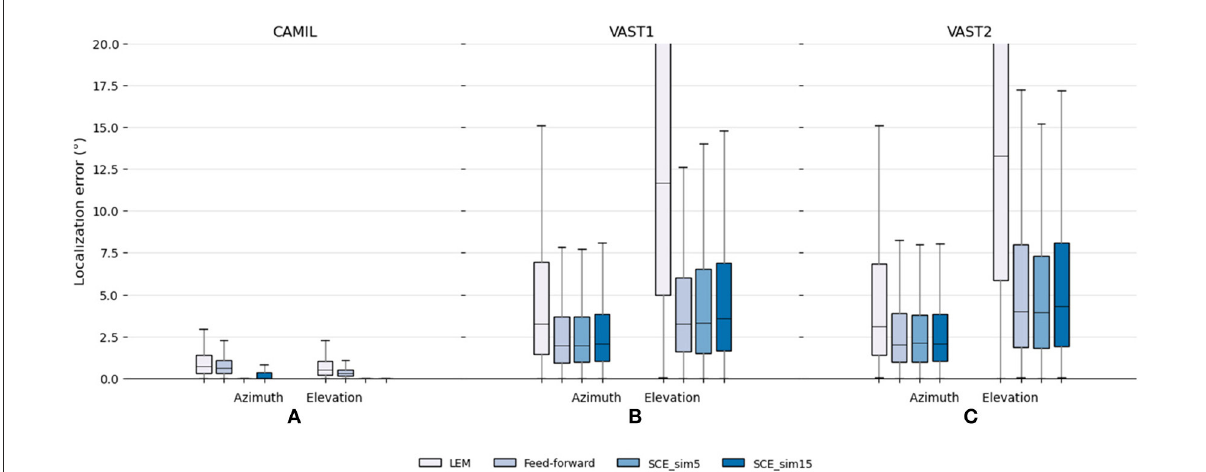
FIGURE3 Testing set localization performance for the baseline LEM, the baseline feed-forward and the proposed SCE methods. Localization errors in (A) the fixed acoustic condition using the CAMIL testing set, and (B,C) the localization performance in the varying acoustic condition using the VAST testing sets. “_sim5” and “_sim15” denote the use of similarity threshold angles ǫ u equal to 5 and 15 ◦ , respectively.